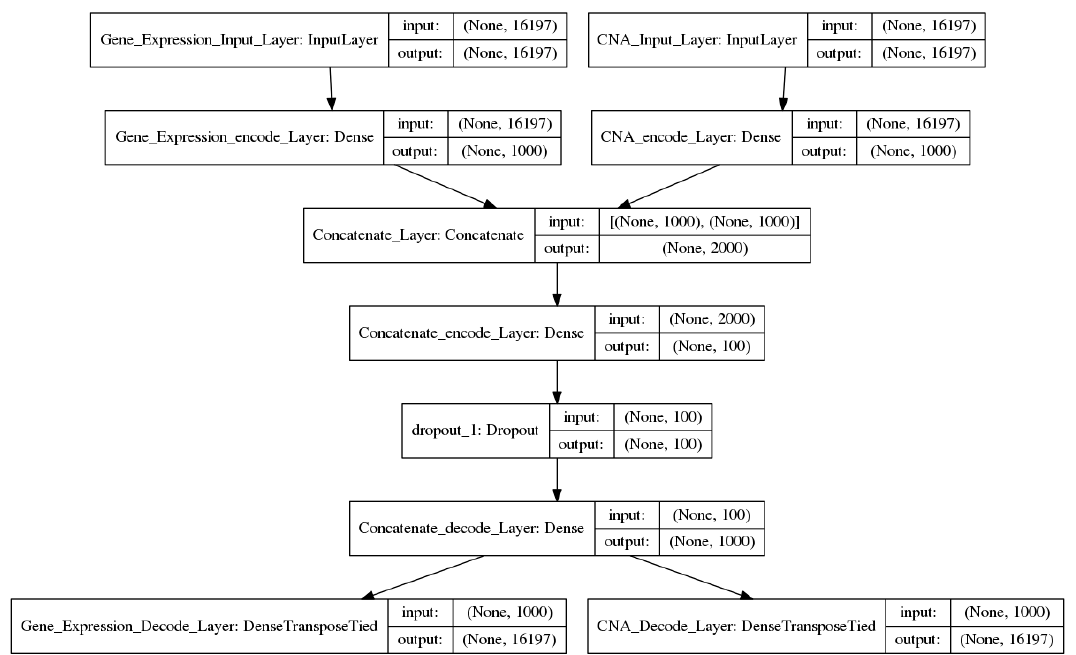
Figure 3. The two-input DAs model. There are two hidden layers in the encode phase and one decode layer. Concatenation was performed between the two encode layers.